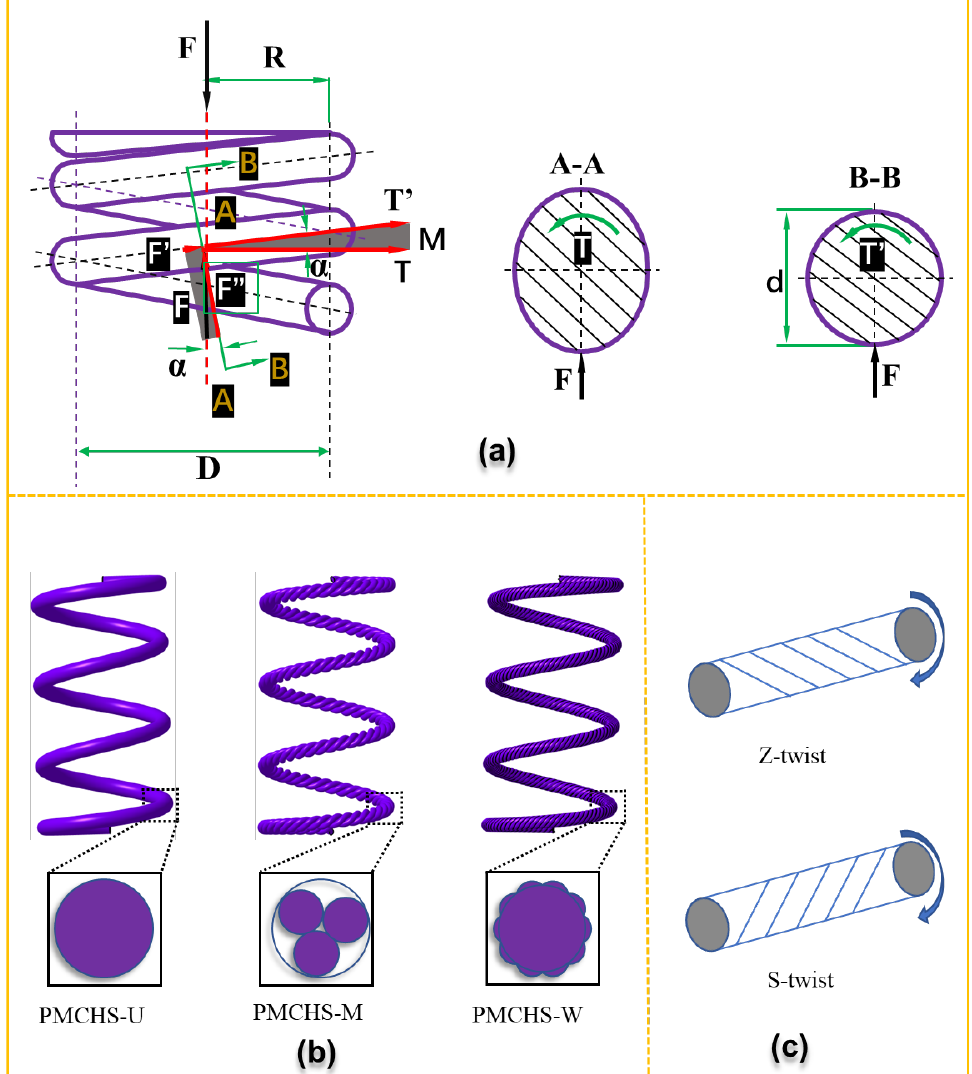
Figure 1. ( a ) Force analysis of a PMCHS under compression with the cross-sectional information in A–A and B–B, ( b ) PMCHSs with unidirectional, multistrand, and wrapped reinforcement structures (PMCHS-U, PMCHS-M, and PMCHS-W), and ( c ) force analysis of reinforcement with different twist directions, i.e., Z-twist (the direction of shear stress is opposite to the twist direction) and S-twist (the direction of shear stress is the same as the twist direction).